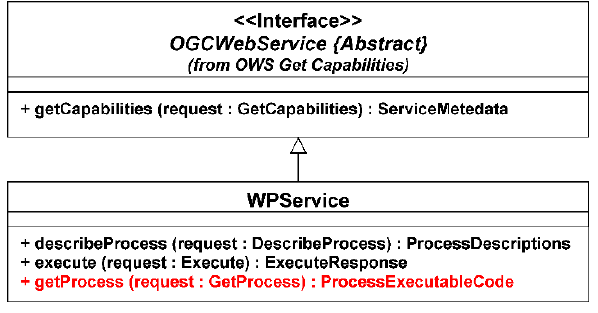
Figure 1. Modified WPS Interface Diagram with getProcess method